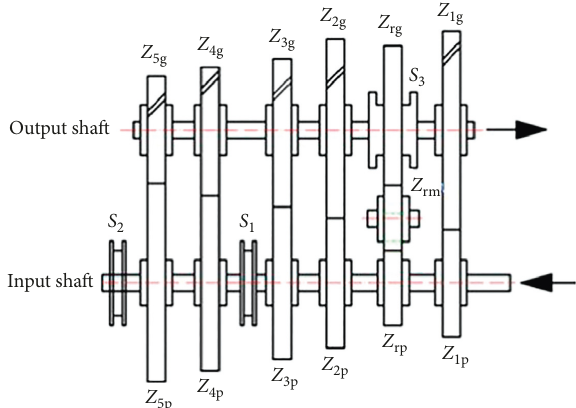
Figure 15: Schematic diagram of multistage